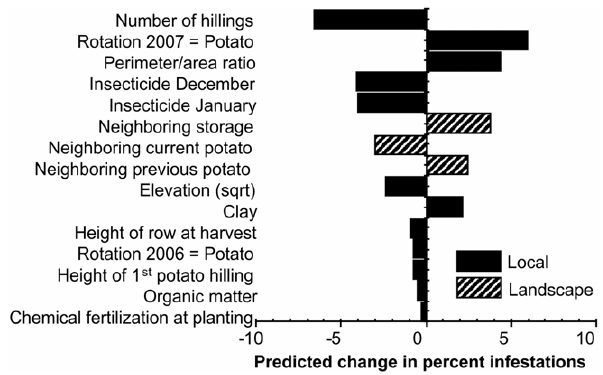
Figure 6. Standardized predicted impacts of explanatory variables on Andean potato infestations. The model is initially set to predict infestations for a field with no pesticide applications and with mean (for continuous variables) or most common (for ordinal and categorical variables) values for all other explanatory variables. For continuous explanatory variables, bars reflect predicted changes in infestations in response to a one standard deviation increase in the explanatory variable. For ordinal explanatory variables, the bars reflect predicted changes in infestations in response to a single unit increase in the explanatory variable; except for the number of hillings, for which only a decrease could maintain predictions within observed bounds.To obtain multi-model predictions, parameter estimates were multiplied by their corresponding parameter weights. Hence, predicted effects are ‘‘attenuated’’ for explanatory variables with parameter weights smaller than 1. doi:10.1371/journal.pone.0036533.g006 insecticide treatments before - but not after - February, (2) the efficacy of implementing a single potato-free rotation period, and the trends of decreasing infestations with increasing (3) elevation, (4) field perimeter-to-area ratio and (5) hilling height. At the landscape level, our results support the suspected influence of (6) Table 3. Parameter estimates 6 SEM for the best models predicting Andean weevil infestations based on local factors only (i.e. Best local), landscape factors only (i.e. Best landscape) or both local and landscape factors together (i.e. Best combined).